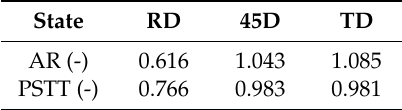
Table 4. Anisotropy coe ffi cients of the Inco718 material (mean value, where the deviation was less than 0.03 in all